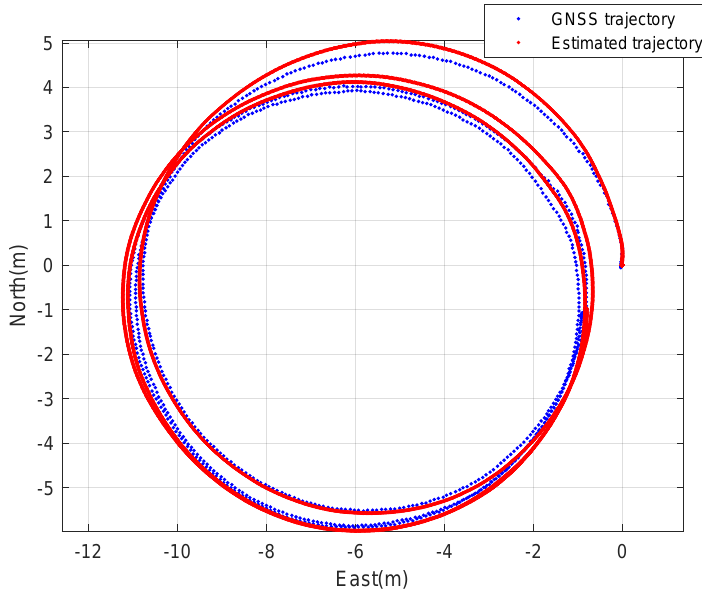
Figure 6. The 2D trajectory of the rover: a circular driving test.